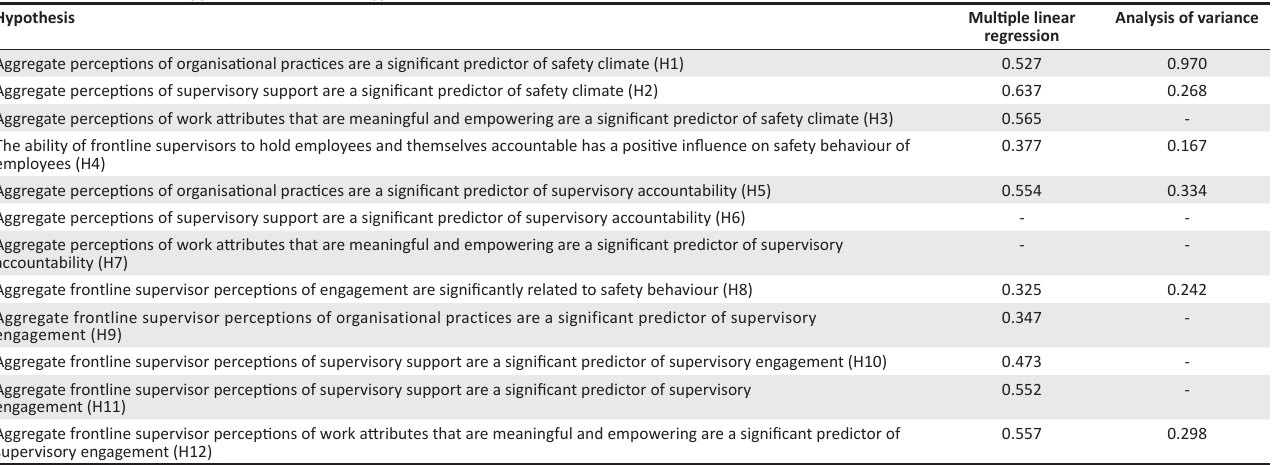
TABLE 1: Statistical tests applied to the research hypotheses.